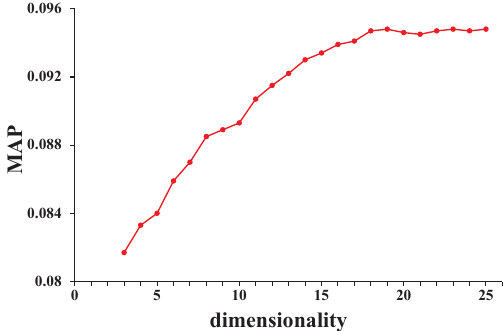
Figure 2. MAP performance of MST-RNN with varying dimensionality d .